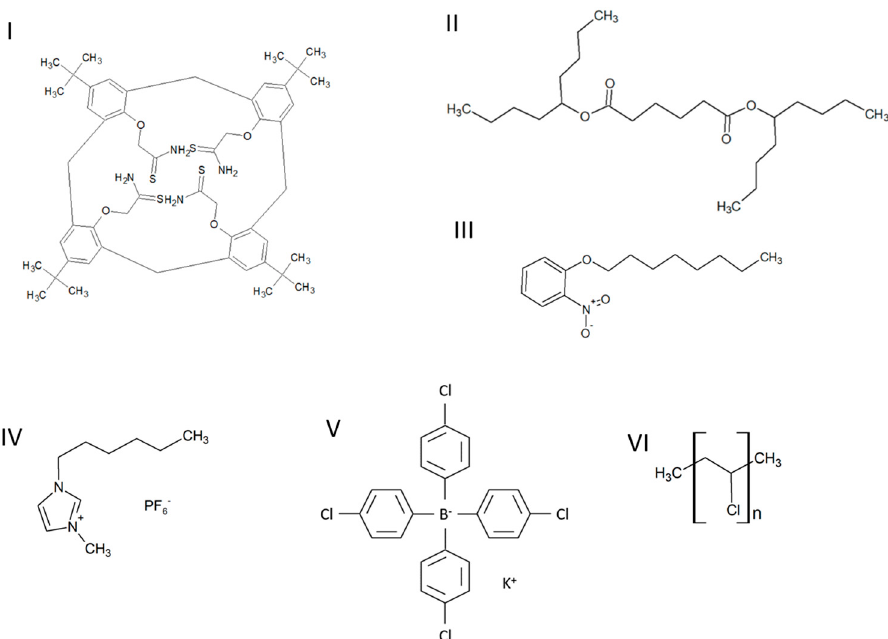
Figure 1. The chemical formulas of the compounds used to prepare the membranes: ( I ) lead ionophore IV, ( II ) bis(1-butylpentyl) adipate, ( III ) 2-nitrophenyl octyl ether, ( IV ) 1-hexyl-3-methylimidazolium hexafluorophosphate, ( V ) potassium tetrakis (p-chlorophenyl) borate and ( VI ) poly(vinyl chloride).